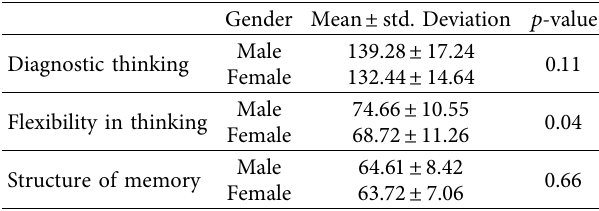
Table 4: Diagnostic thinking scores of students by gender.